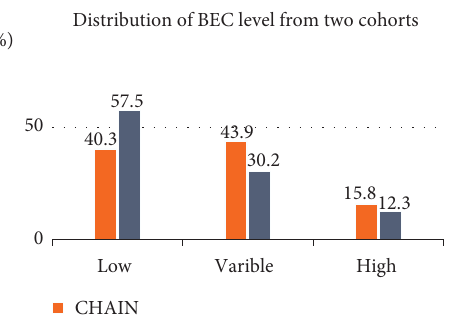
Figure 1: Distribution of BEC level from two cohorts. CHAIN: history of asthma was not excluded. BODE: history of asthma was excluded; cutoff value: 300 cells/ μ L.